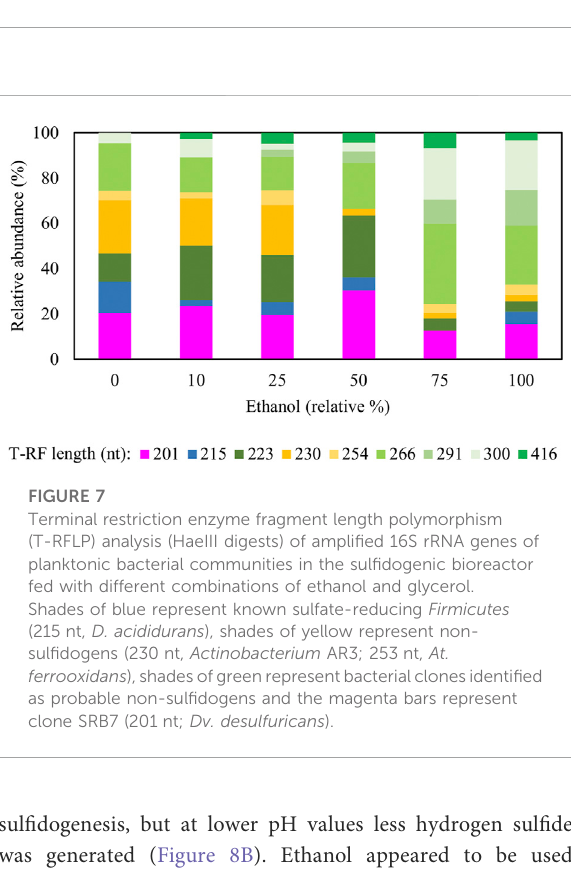
FIGURE 5 (A) Changes in HRTs ( C ) with different relative percentages of ethanol ( ■ ) present in the feed liquor of the sul fi dogenic bioreactor, and (B) variations in rates of sulfate reduction (blue bars) and hydrogen sul fi de generation (green bars) in each combination of ethanol and glycerol tested ( n = 15). Samples were not analysed in the interval between day 66 and day 90.